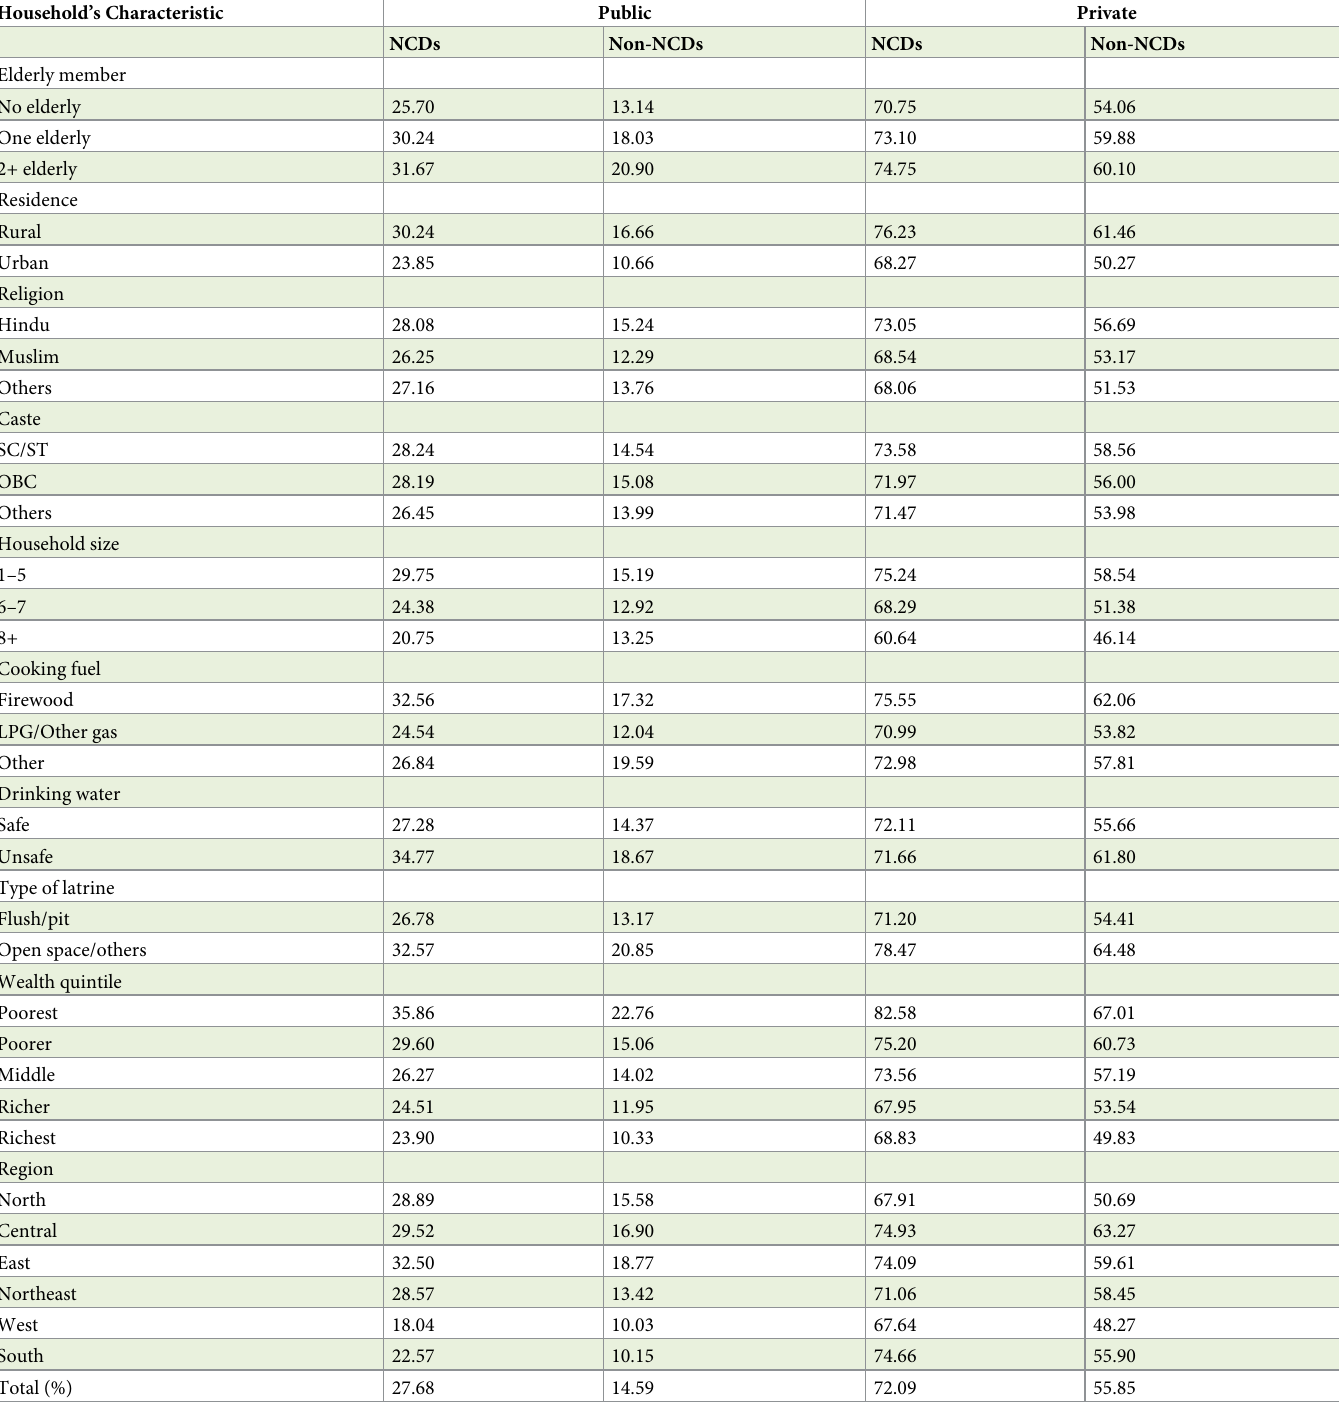
Table 4. Percentage of households experiencing CHE due to hospitalisation by type of facility, NSSO survey